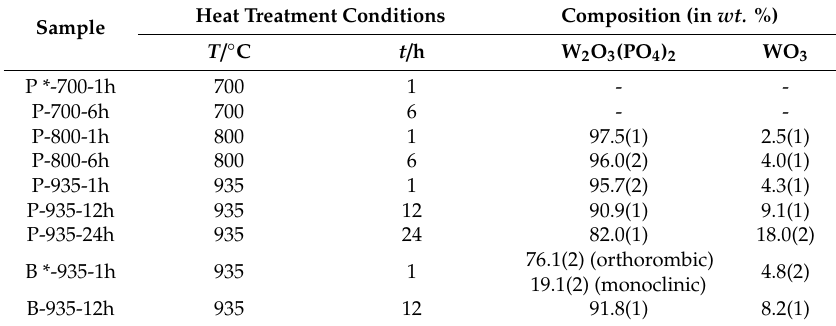
Table 1. Quantitative composition of the samples heat-treated for 1 to 24 h at 700, 800, and 935 ◦ C.